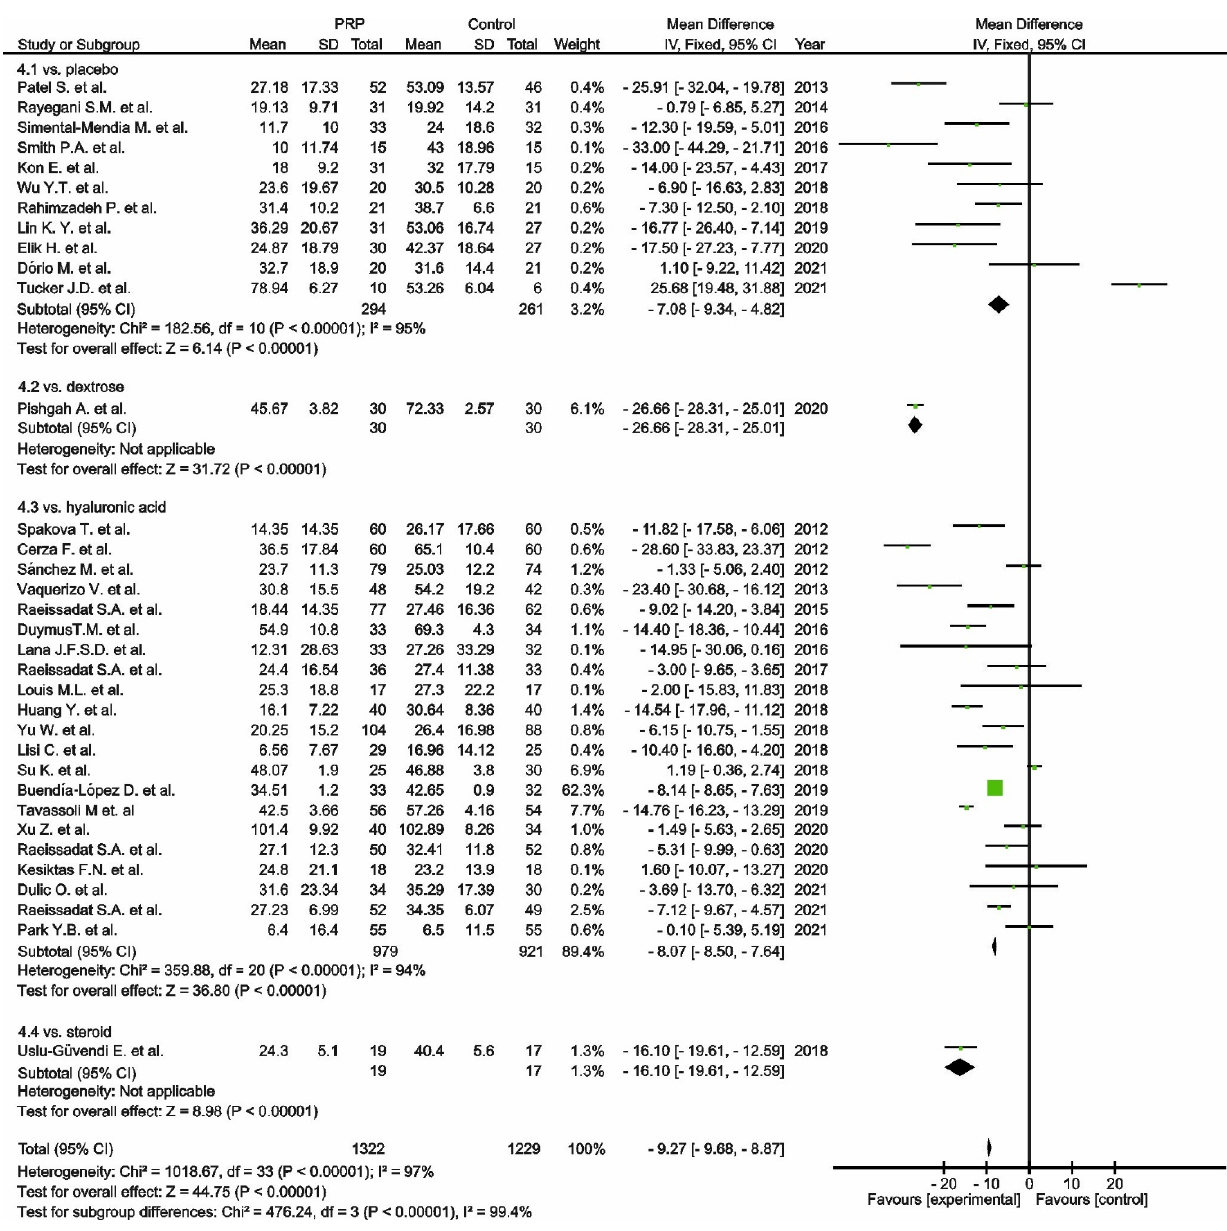
Figure 6. Forest plot for KOOS sub-scores (ADL, activities of daily living; CI, confidence interval; IV, inverse variance; QoL, quality of life; SD, standard deviation; , mean with 95% confidence interval for total and subtotals; , mean with 95% confidence interval for source data).